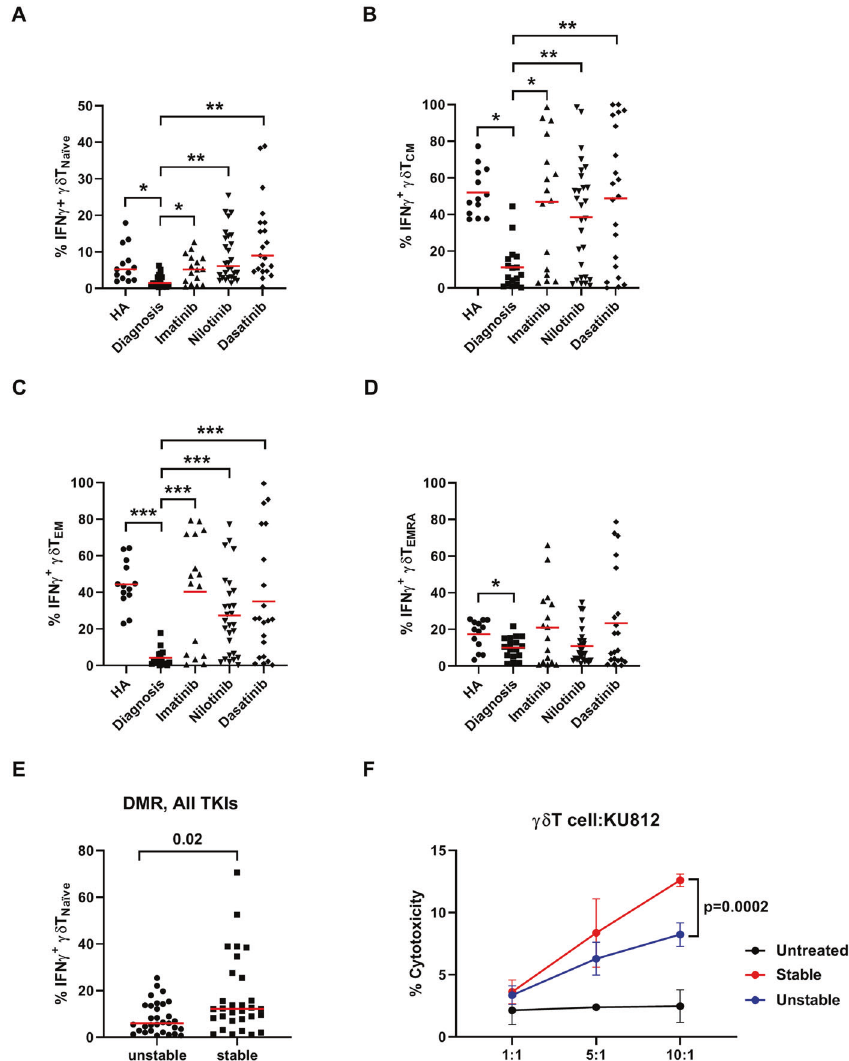
Fig. 5 IFN- γ expressing γδ T phenotypes and cytotoxicity in CML patients on DMR. The four γδ T subsets were identi fi ed by cell surface CD45RA and CD27. The percentages of IFN- γ in the total γδ T cells isolated from patients and healthy controls were compared among ( A ) naïve, B T CM , C T EM , and ( D ) T EMRA γδ T subsets. E Different proportions of IFN- γ + naïve γδ T cells were observed between stable (sustained MR 4.0 ) and unstable patients. F Cytotoxicity assays for isolated γδ T cells from unstable and stable groups. One-way ANOVA was used for comparison between multiple groups, and Bonferroni ’ s post hoc test was used to compare selected pairs. Statistically signi fi cant differences between the groups are marked with asterisks. Data comparison was performed by the Mann – Whitney U test in dot plots. Statistical signi fi cance was de fi ned by * p < 0.05, ** p < 0.01, and *** p < degranulation, we labeled them with CD107a, a surrogate marker for degranulation, and found much higher CD107a + IFN- γ + γδ T levels in patients on DMR than in the untreated patients (36.2% [DMR] vs 18.7% [untreated], p = 0.035) (Fig. 4B). Consistently, the percentage of γδ T cells expressing perforin diminished in patients on DMR, compared to that in untreated patients (25.5% [DMR] vs 35.3% [untreated], p = 0.041) (Fig. 4C). We also determined whether isolated γδ T cells from the patients on pre-MMR, MMR, and DMR could exhibit similar cytotoxicity when they were co- cultured with CML cells (Fig. 4D). We observed an improved leukemia-killing ability of γδ T cells isolated from CML patients with better molecular responses, particularly from patients achieving DMR (DMR to pre-MMR p < 0.0001; DMR to MMR p < 0.0001). Thus, γδ T cells in CML patients on DMR expressed signi fi cantly more cytotoxic molecules, concordant with the fi ndings from the KU812-cell killing assays (Fig. 3C, D).